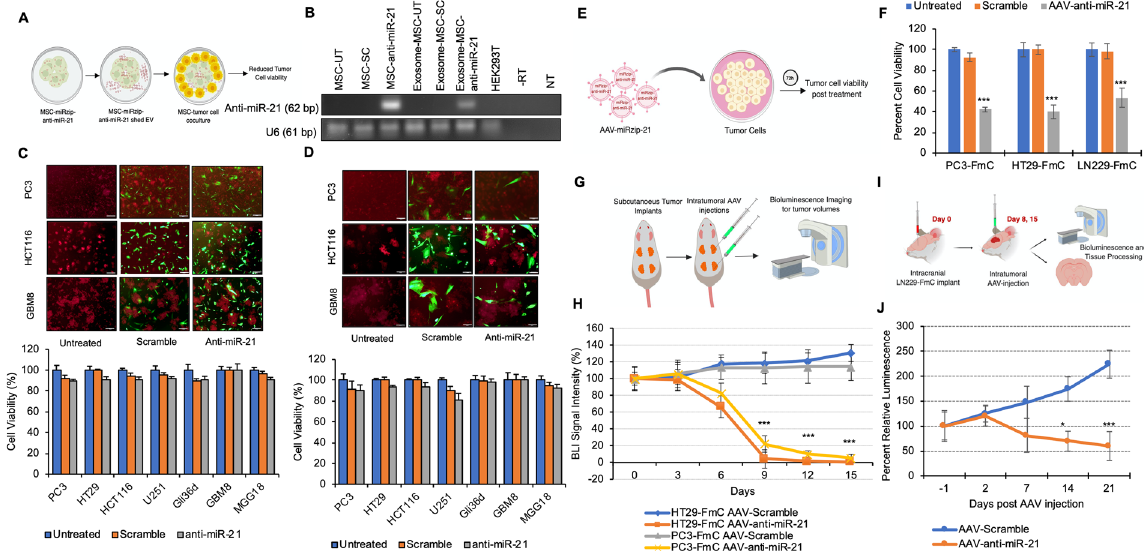
Figure 3. AAV-miRzip-21 effectively reduces cancer cell progression in vivo ( A ) Illustration showing the proposed hypothesis of MSC based delivery of anti-miR-21 to tumor cells. ( B ) RT-PCR assay showing miR-21 expression in LV-miRzip-21 transduced-MSCs and exosomes extracted from transduced MSC. Negative and RT-minus controls are indicated by NT and -RT, respectively. UT and SC represent untreated and scramble control groups, respectively. ( C ) Plots and representative fluorescent micrographs of cancer cells cocultured with LV-miRzip-21 expressing MSCs at 3:1 ratio showing cell viability at 120 h. Scale bars: 100 uM ( D ) Plots and representative fluorescent micrographs of cancer cells cocultured with LV-miRzip-21 infected-MSCs at 1:1 ratio and corresponding cell viability at 120 h. Scale bars: 50 uM ( E ) Illustration showing the model for AAV transduction of tumor cells ( F ) Plot showing changes in tumor cell viability at 72 h post transduction with AAV- miRzip-21 and control. ( G ) Illustration of the in vivo subcutaneous model of colon and prostate cancers. ( H ) Plot showing changes in bioluminescence signal intensity overtime following AAV-miRzip-21 injection. ( I ) Illustration of the intracranial LN229-FmC animal model. ( J ) Plot showing changes in bioluminescence signal intensity overtime following AAV injection. Data presented as mean ± SD. *** (P < 0.01) and * (P <